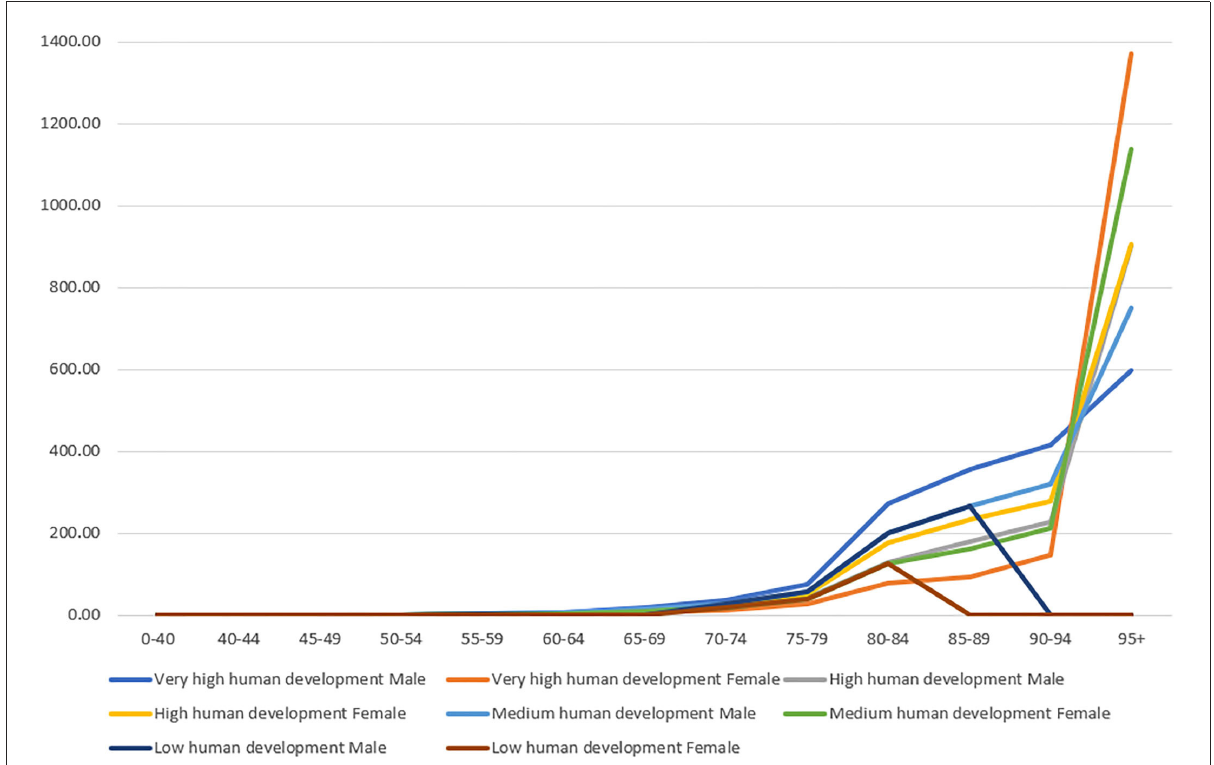
FIGURE3 Joinpoint regression analysis showing the differences in the trends of Parkinson’s mortality according to the classification of HDI.